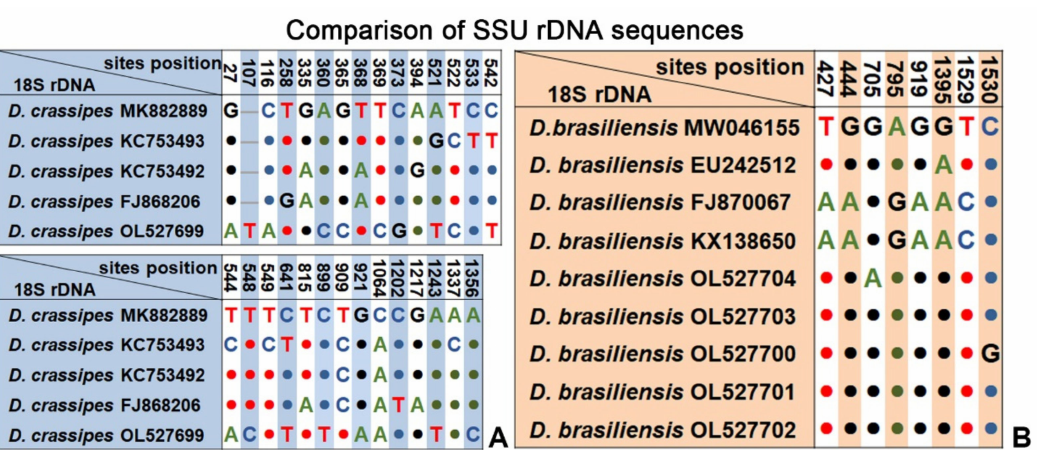
Figure 5. Sequence comparison of the SSU rRNA gene showing the unmatched nucleotides be- tween the Ningbo population of Dysteria crassipes and other populations of D. crassipes ( A ) and the unmatched nucleotides among the Ningbo populations of D. brasiliensis and other populations of D. brasiliensis ( B ). Nucleotide positions are given at the top of each column. Insertions and deletions are compensated by introducing alignment gaps (-). Matched sites are represented by dots ( · ).